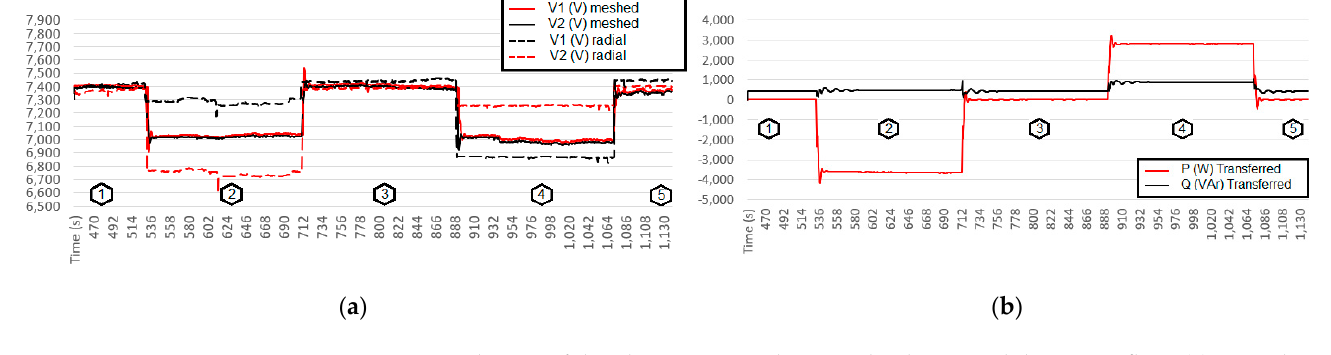
Figure 12 . Behavior of the phase-to-ground terminal voltages and the power flow; ( a ) V 1 and V 2 ; ( b ) transferred P and Q.